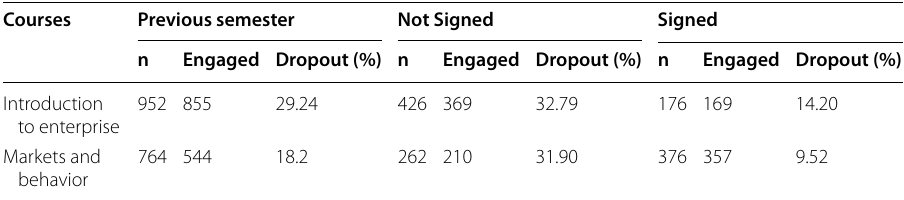
Courses Previous